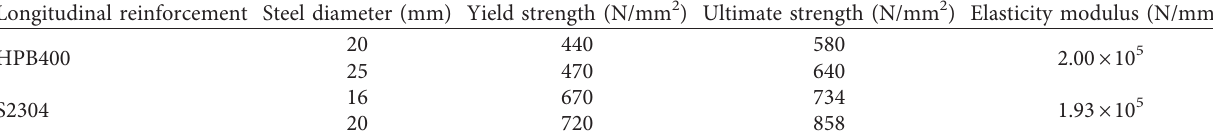
Table 4: Properties of the reinforcement materials.